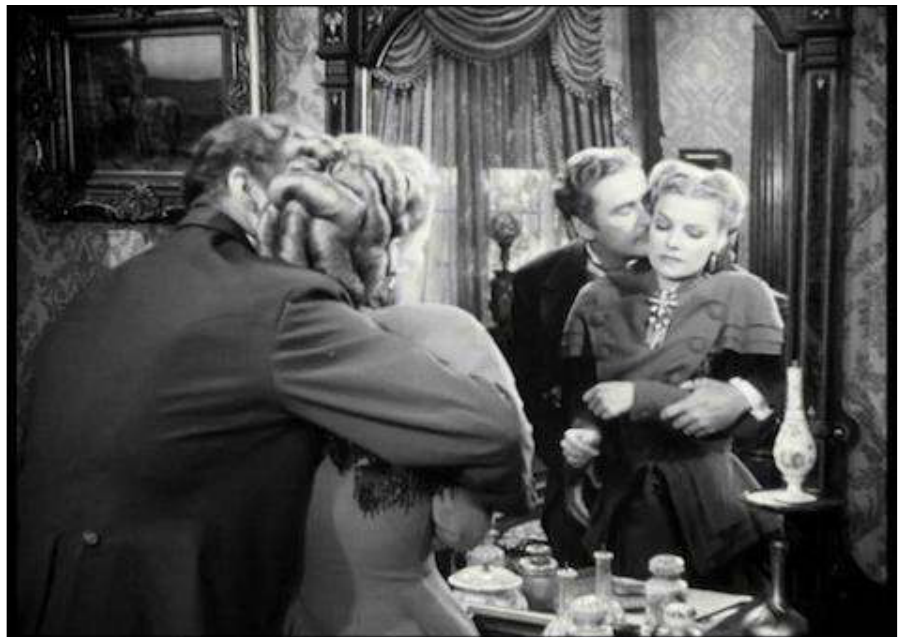
Figure 23: Georgia refusing Mike’s kisses in Silver River